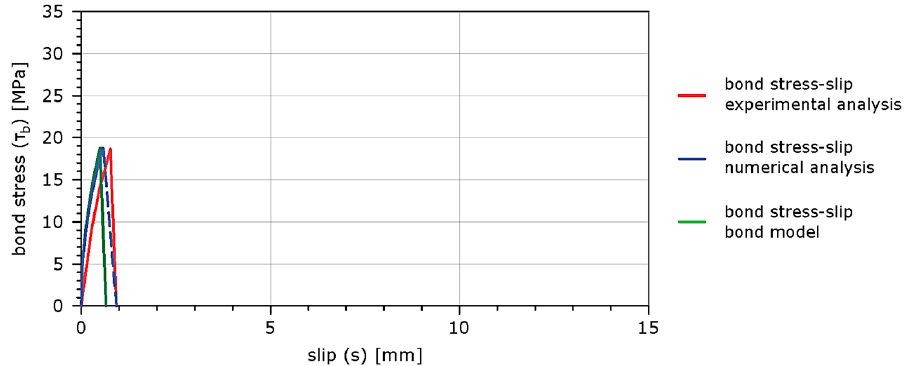
Figure 18. Comparison of bond stress-slip curves for the POT-16 series. The numerical simulation of the POT-16 series was not completed due to convergence problems. The dashed line for the numerical curve is an extension of the curve where the calculations stopped. Based on Figure 18, there is good agreement between the numerical curve and the curve from the bond model in the pre-peak range. The experimental curve differs from the other two. This is because it is a curve averaging the results of the six specimens of the POT-16 series, which had the largest scatters (see Table 10).